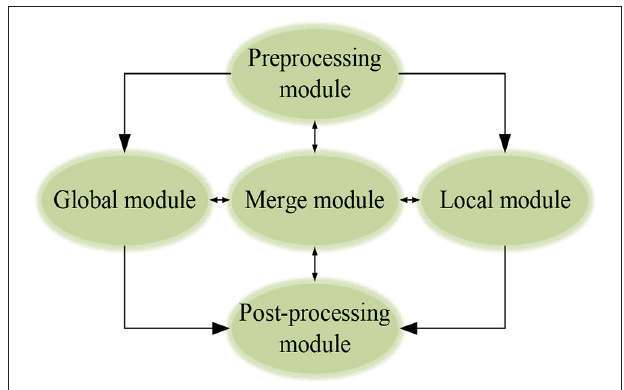
FIGURE 5 | The modular expression